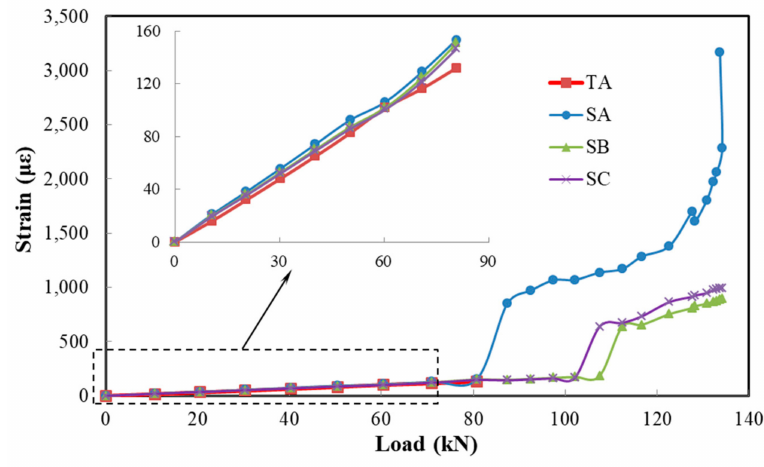
Figure 11. Strains of composite film sensors (SA, SB, and SC) and traditional resistance strain gauge (TA) during loading.